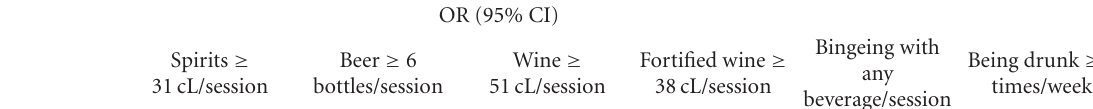
Table 4: Questionnaire-based childhood data. Odds ratios (OR) for the relationship between adverse childhood experiences and binge drinking and drunkenness in the KIHD study ( n =